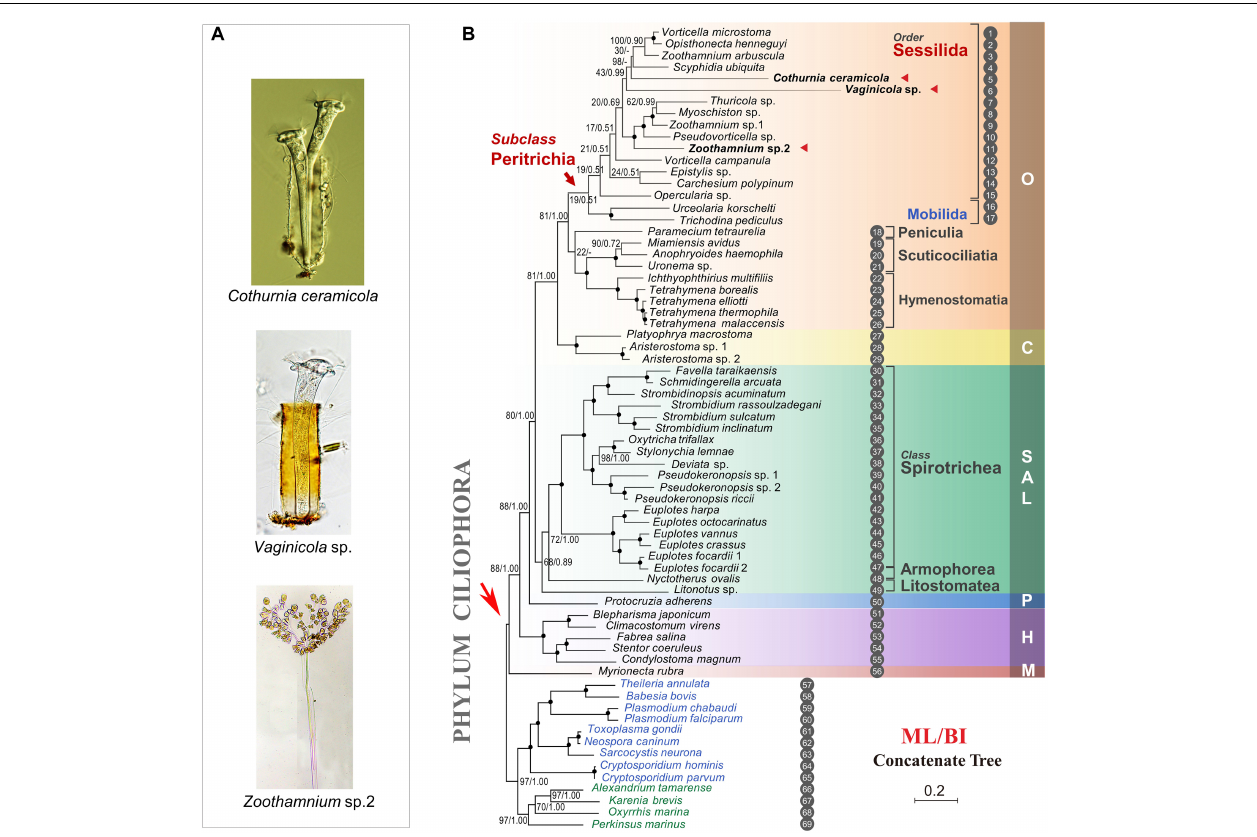
FIGURE 2 | Phylogenomic analysis based on genome-wide homolog protein sequences. (A) Photomicrographs of Cothurnia ceramicola , Vaginicola sp., and Zoothamnium sp. 2 (B) Phylogenomic trees estimated from a 157-gene concatenated dataset by maximum likelihood (ML) and Bayesian inference (BI). Black dots denote full support (ML 100%/BI 1.0). Hyphens denote topological disagreement between BI and ML analyses. The three sessilid peritrichs sequenced in the current work are in bold and are marked by red triangles. The outgroup taxa, nine apicomplexans, and four dinoflagellates, are in blue and green, respectively. SAL, classes Spirotrichea, Armophorea, and Litostomatea; O, class Oligohymenophorea; C, class Colpodea; P, class Protocruziea; H, class Heterotrichea; and M, class Mesodiniea. Scale bar corresponds to 20 substitutions per 100 nucleotide positions. The numbers in the circles adjacent to species names correspond to those in Supplementary Table 1 and Supplementary Figure 1 .